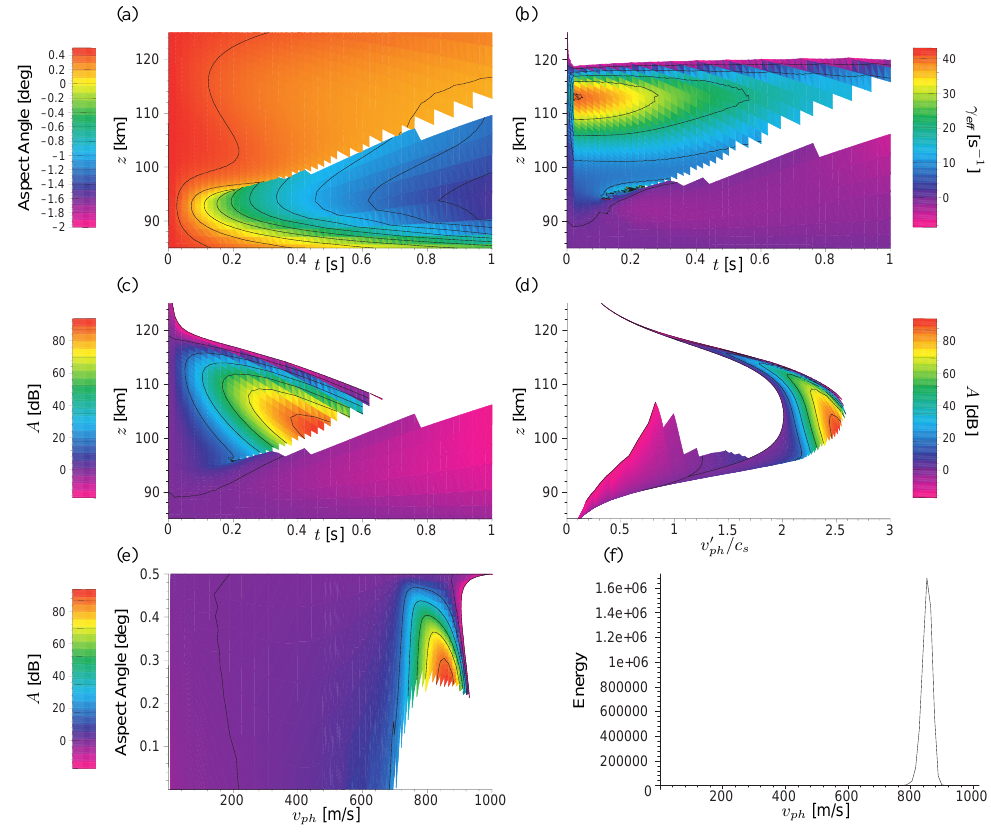
Fig. 10. Same as in Fig. 10, but with a uniform aspect angle of + 0 . 5 ◦